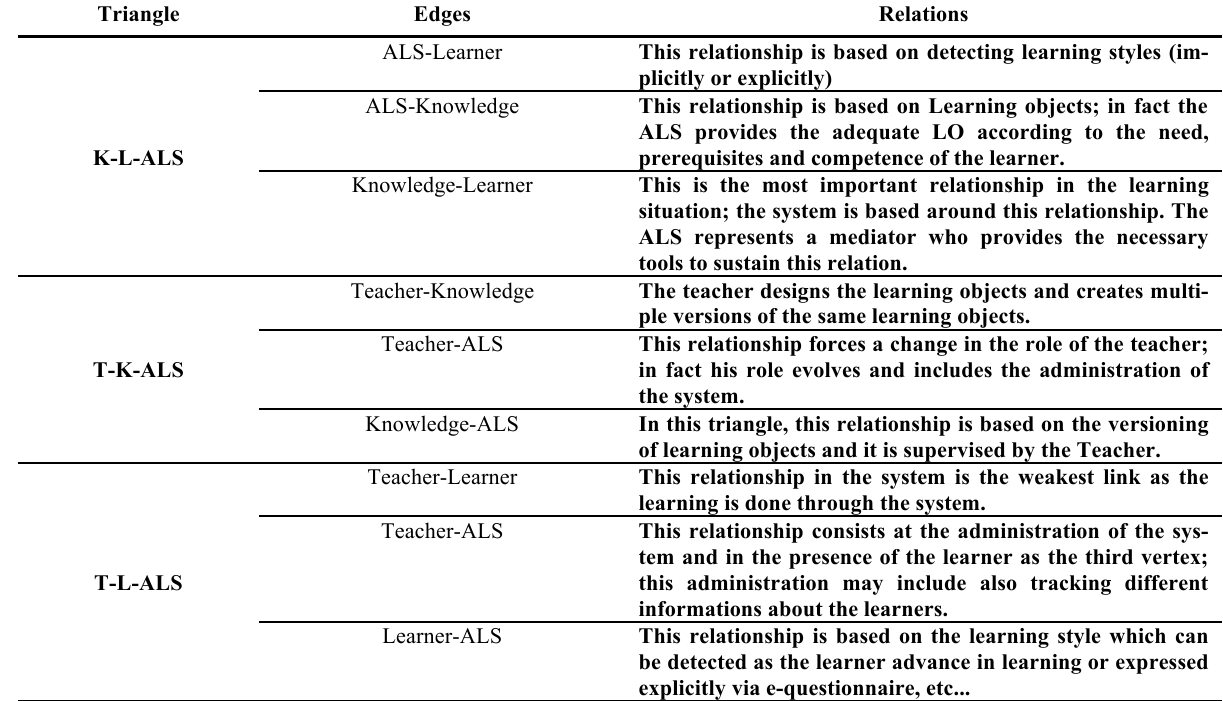
TABLE II. A RECAP OF THE RELATIONSHIPS INSIDE THE ALS T